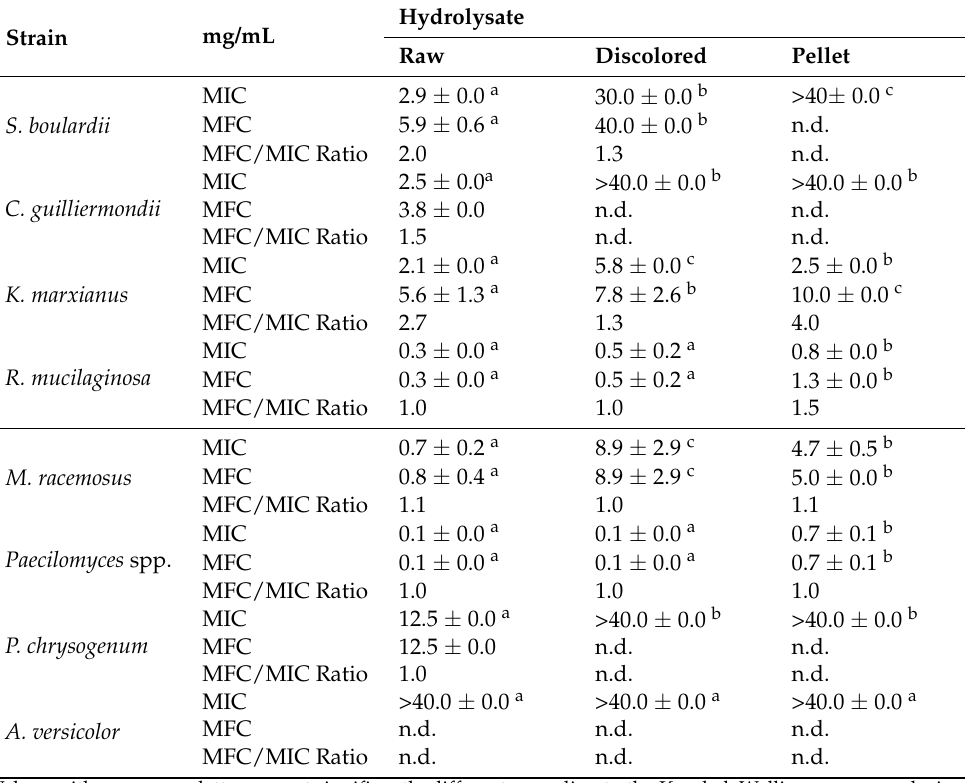
Table 6. Minimal Inhibitory Concentration (MIC) and Minimal Fungicidal Concentration (MFC) of raw and discolored porcine cruor hydrolysates on different strains of yeasts and molds. Strain